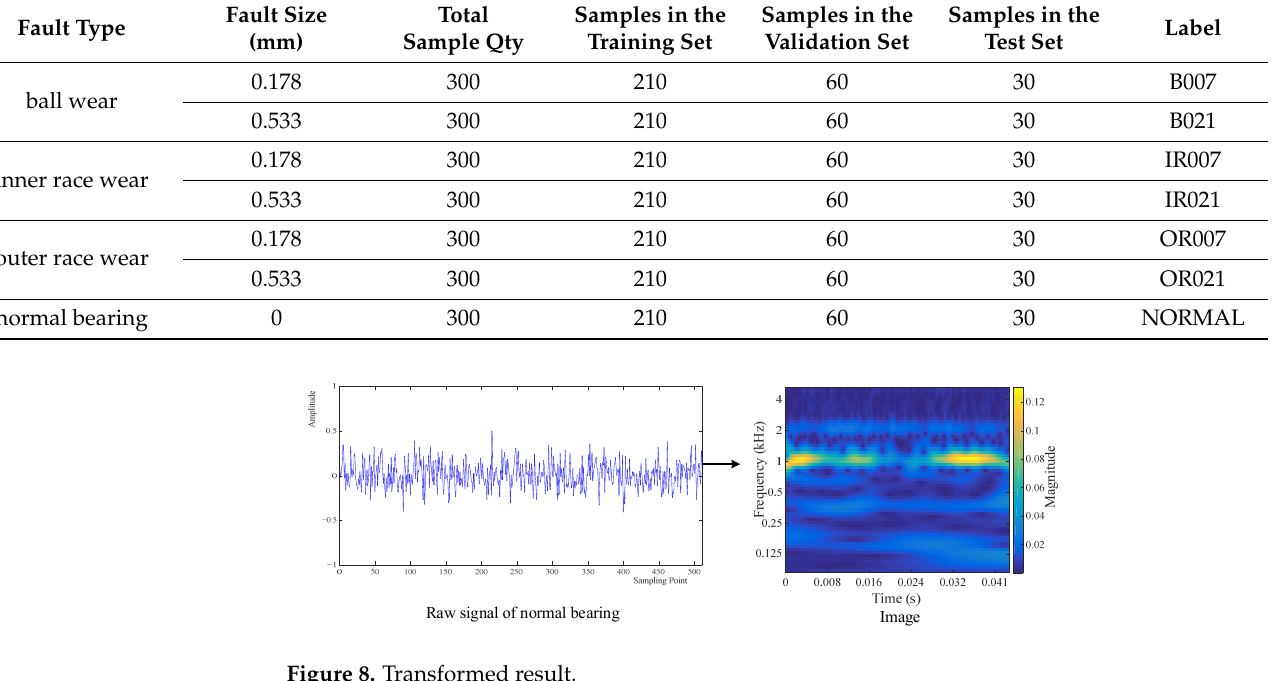
Table 6. Introduction to image data sets.